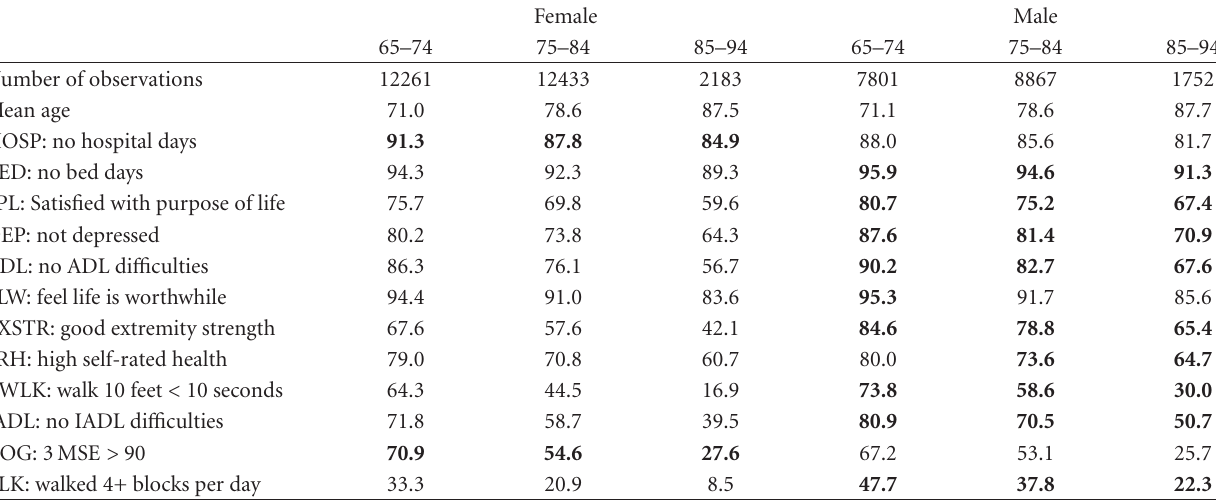
Table 2: Prevalence of a healthy state among men and women, with health defined separately for each domain. Bolded entries represent significantly higher prevalence of health in women (left columns) or men (right columns). The di ff erences between groups based on age are described in the text.